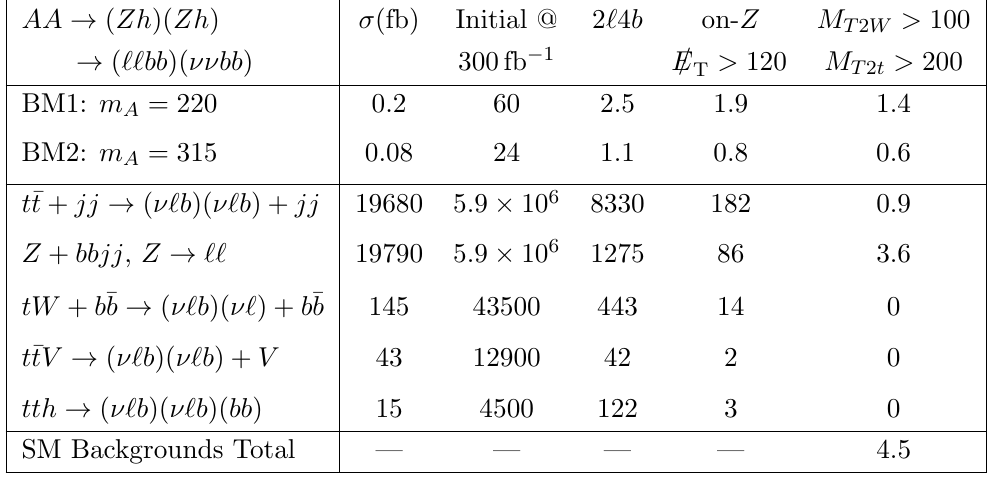
(cid:0) (cid:1) pp ! AA ! ( Zh )( Zh ) (cid:2) 2Br( Z ! ‘ (cid:22) ‘ )Br( Z ! =v in the signal benchmarks. j = u; c; d; s; b; g . A